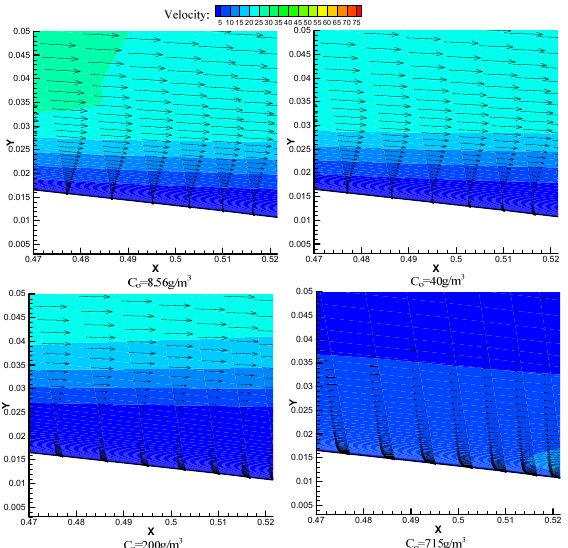
Figure 9. Effect of different concentrations of particles on the velocity gradient of the airfoil boundary